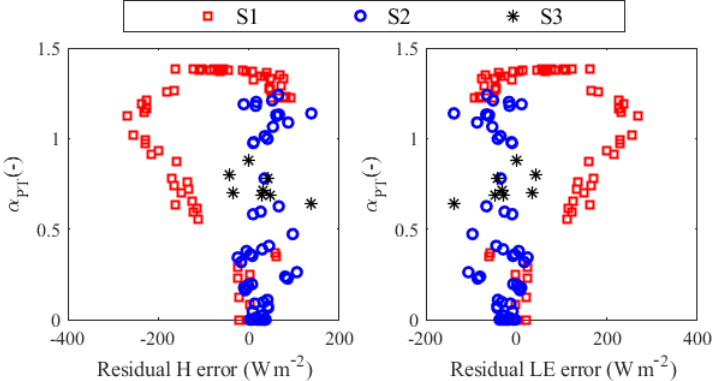
Figure 12. α PT vs. residual H and LE